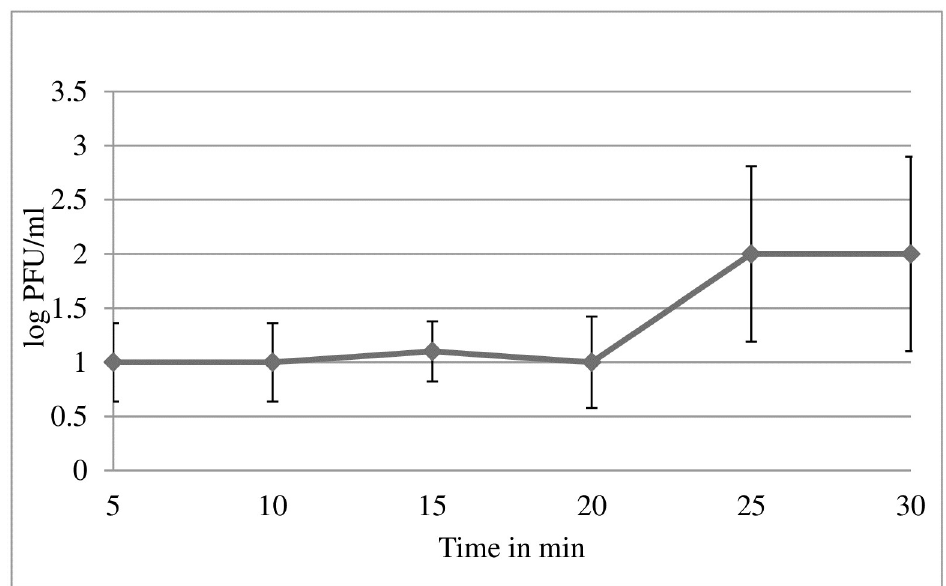
Fig 3. Growth curve of phage UPM2146. One step growth curve of UPM2146 taking 20 min of latent period, 5 min of rise period, and exponential phase of 10 min. Total time required to lyse its host was 25 min that is characteristic of lytic phages. The experiment was done in